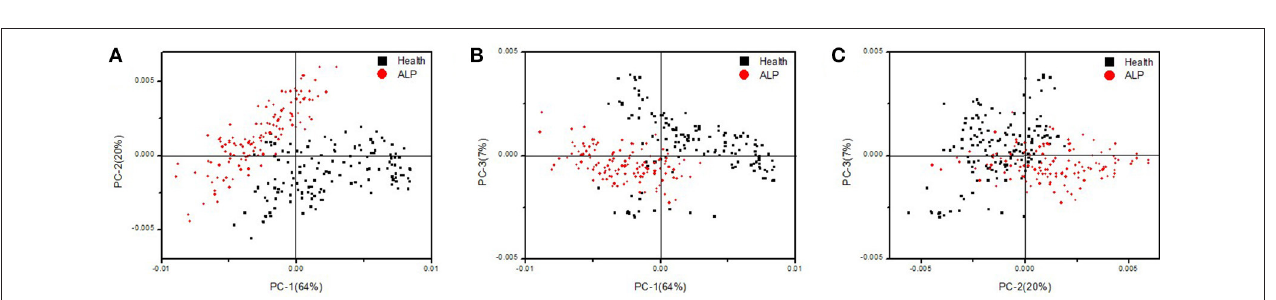
Frontiers in Chemistry |